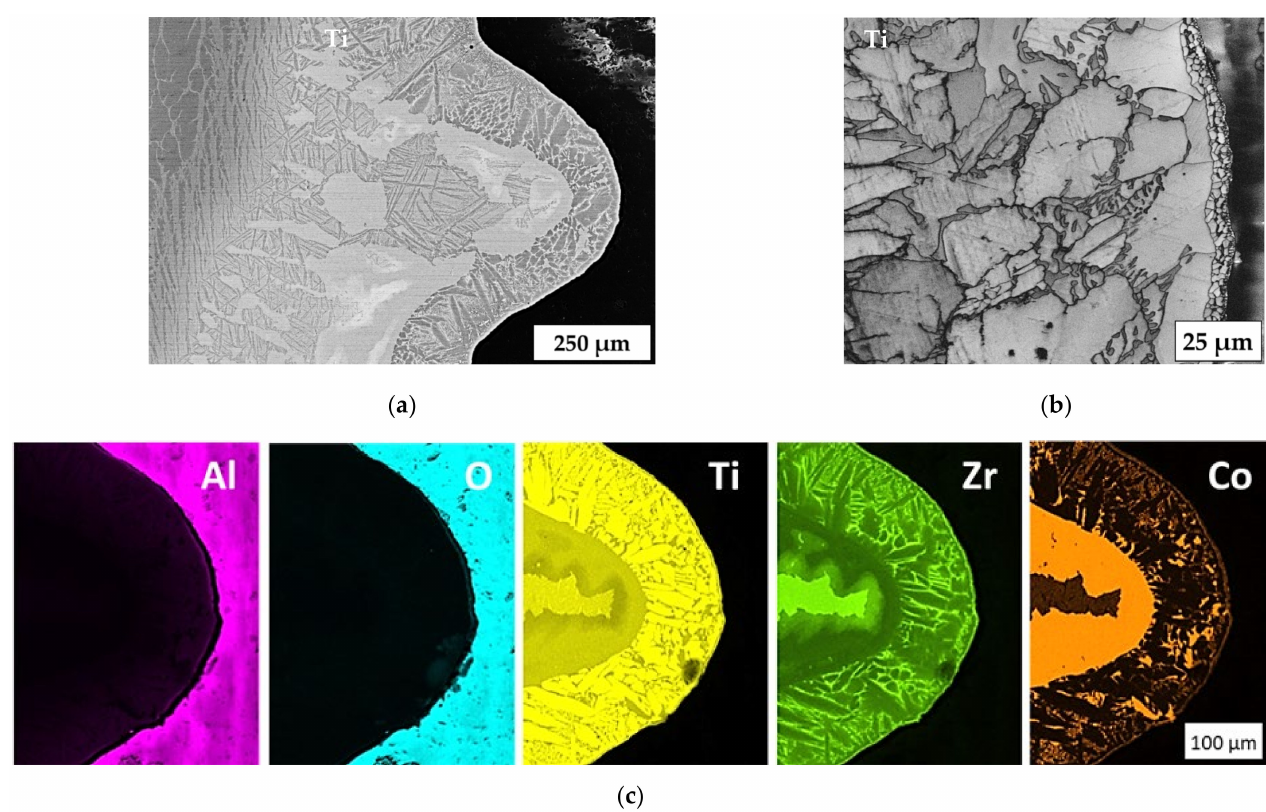
Figure 9. ( a ) SEM-BSE image at magnification of 100 × , ( b ) EBSD band contrast image at magnification of 500 × , and ( c ) EDX mapping at magnification of 250 × with 15 kV of the brazed seam in a notch located near the bottom side. Another structure of the brazed joint was observed in the central zone of the sample,